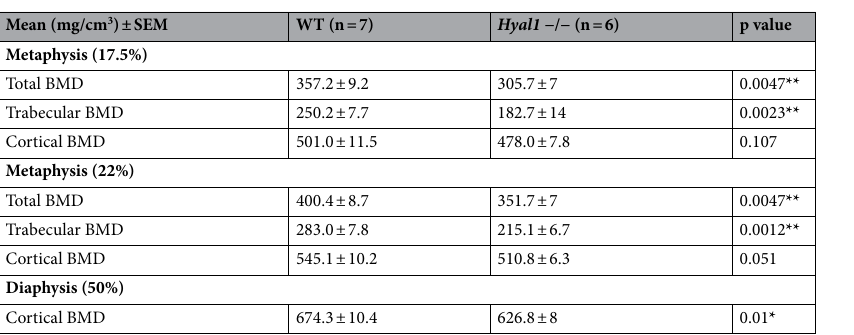
Table 1. Bone mineral density (BMD; mg/cm 3 ) of right femurs isolated from 1-year-old WT or Hyal1 −/− male mice. The BMD was measured using peripheral Quantitative Computed Tomography at 17.5, 22, 50% distance from the distal extremity of the femurs. Two-tailed Mann–Whitney U tests were applied to the results. *p < 0.05, **p <